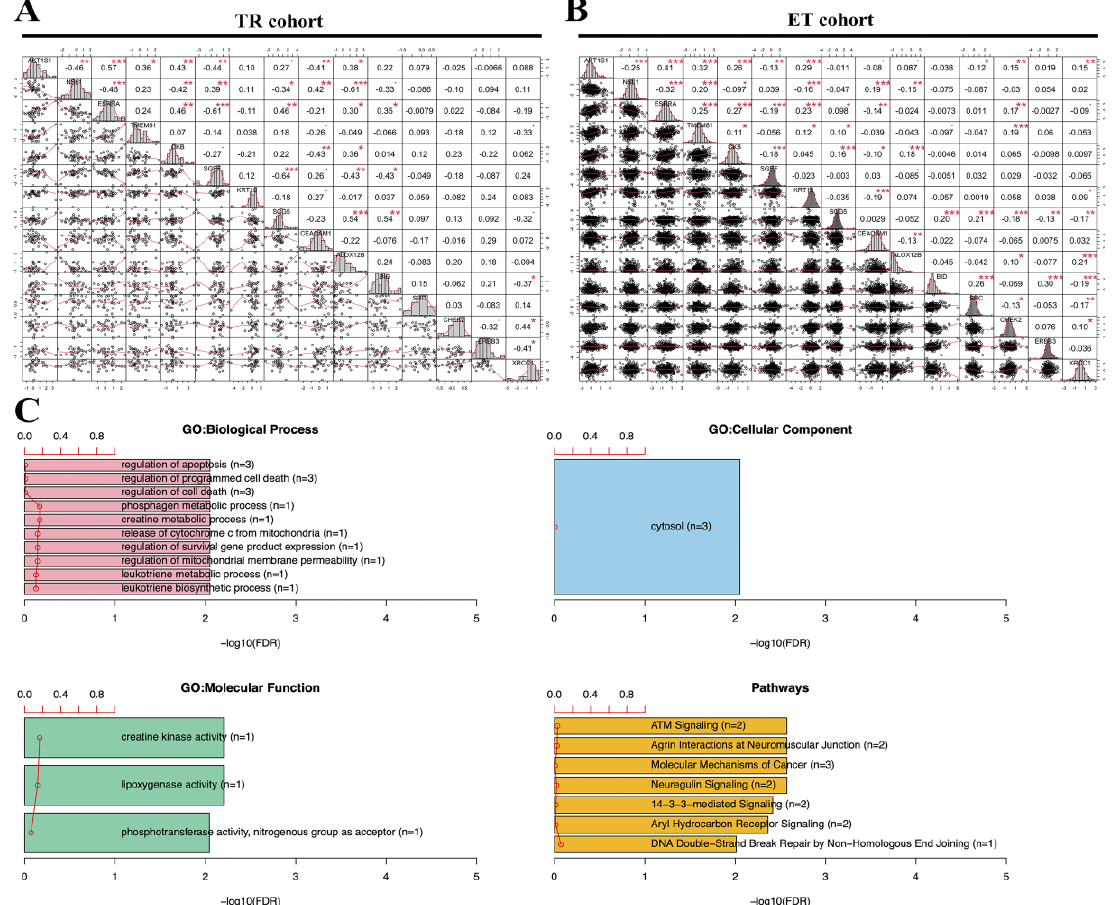
Figure 5. Correlation matrix and GSEA analysis of candidate gene set with 15 targets. ( A , B ) Most of the candidate gene sets were significantly correlated with each other in both cohorts. ( C ) The main function of the candidate gene set was associated with cell death, metabolic process, kinase activity, neuregulin, DNA double − strand break repair, and cancer − related signaling pathways. A p value less than * p < 0.05, ** p < 0.01, and *** p < 0.001 was considered statistically